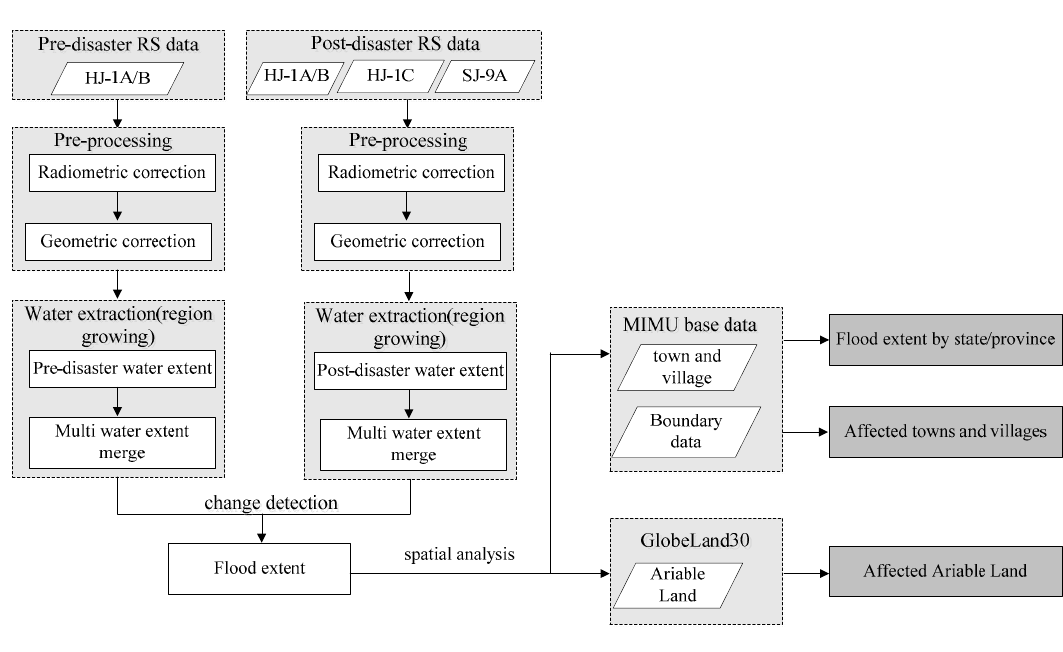
Figure 5. Flood Impact Estimation Workflow.